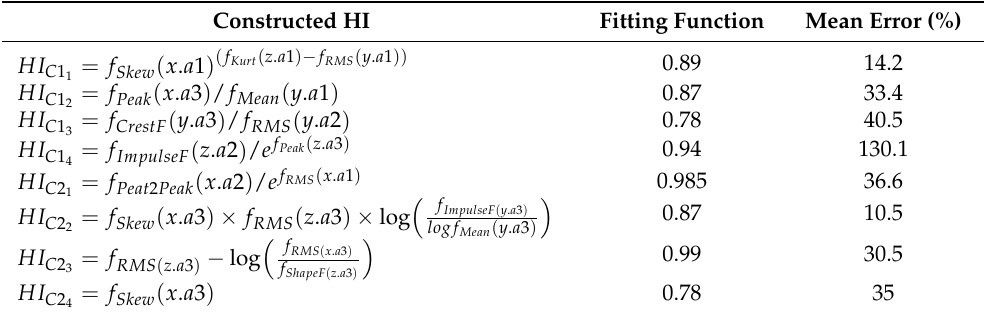
Table 10. HI construction GP.